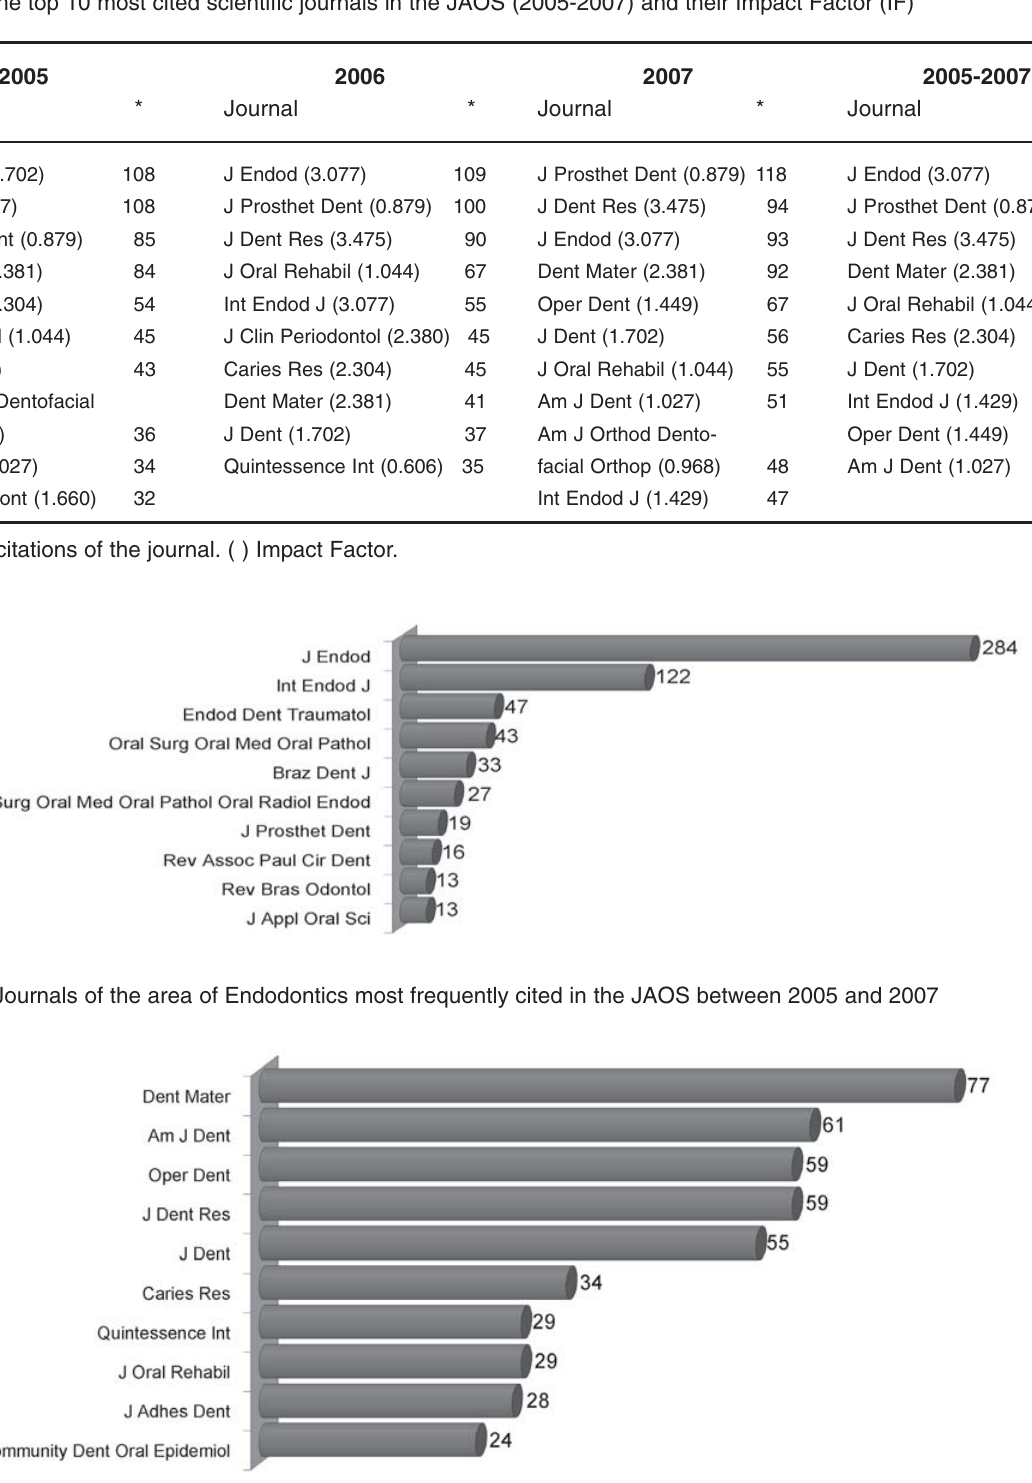
FIGURE 4- Journals of the area of Restorative Dentistry most frequently cited in the JAOS between 2005 and